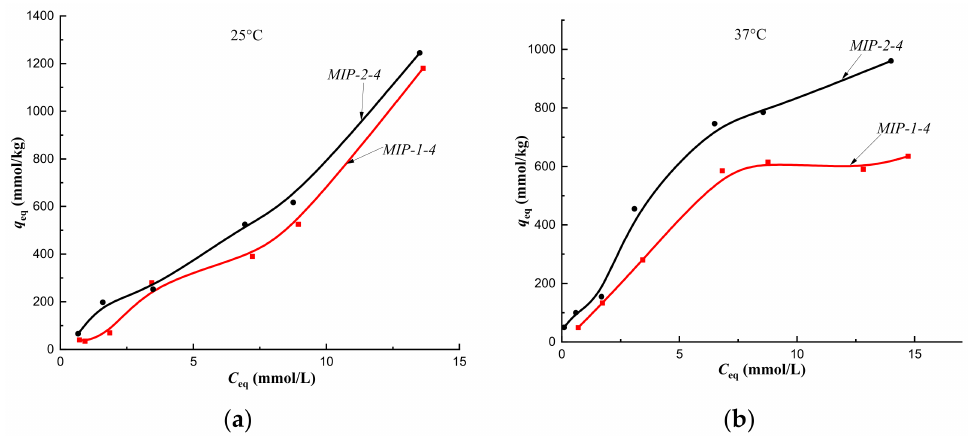
Figure 8. Isotherms of sorption of cholesterol on MIP-1-2 and MIP-2-2 at a temperature of 25 ◦ C ( a ) and at a temperature of 37 ◦ C ( b ) (fraction 160–315 µ m).